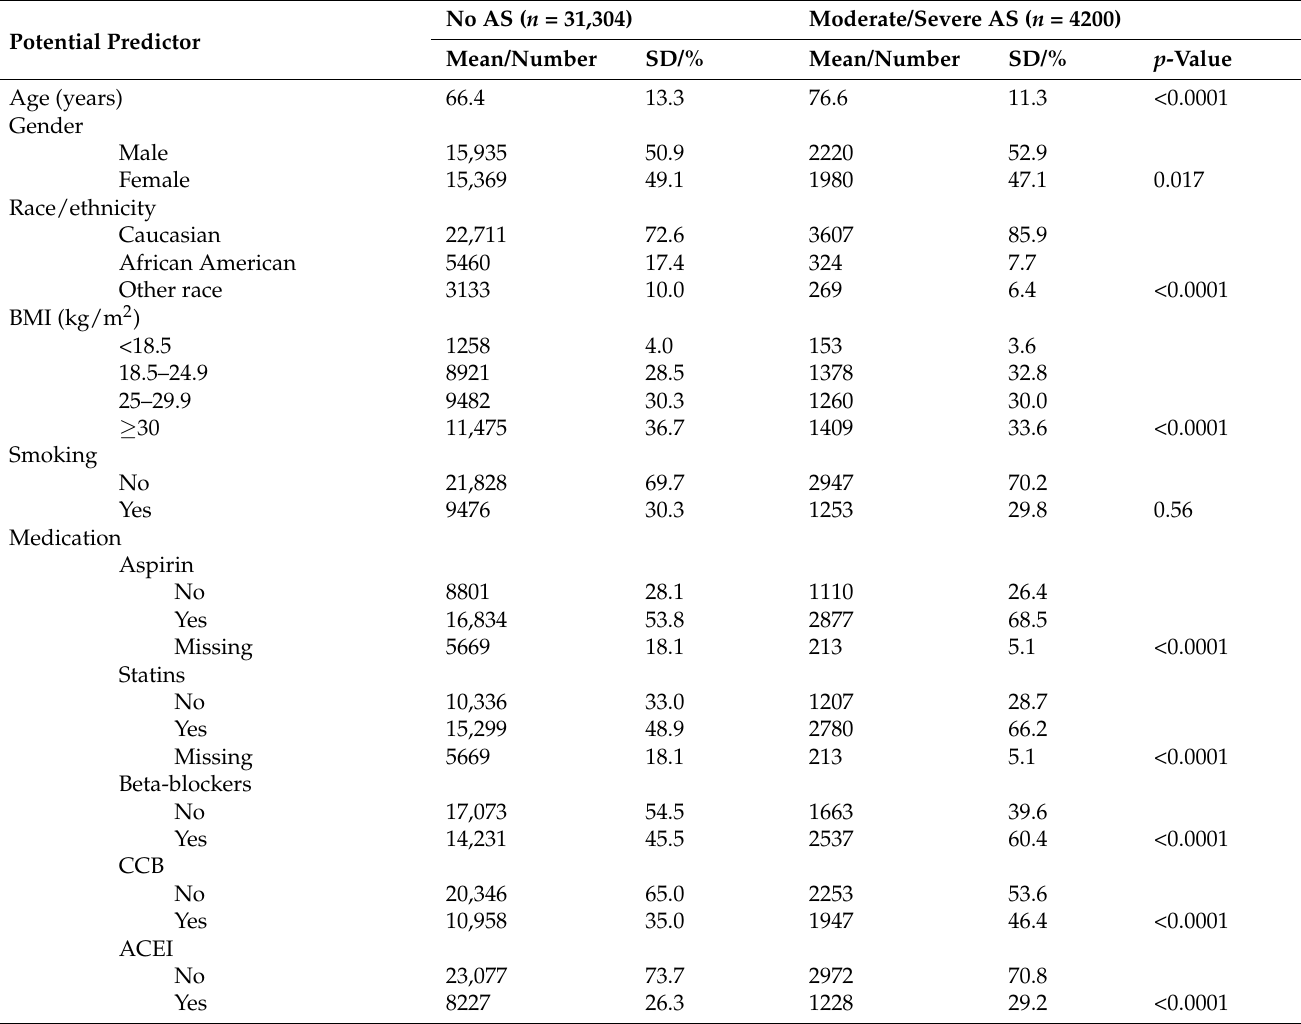
Table 1. Distribution of the potential predictors between patients with advanced AS and those without